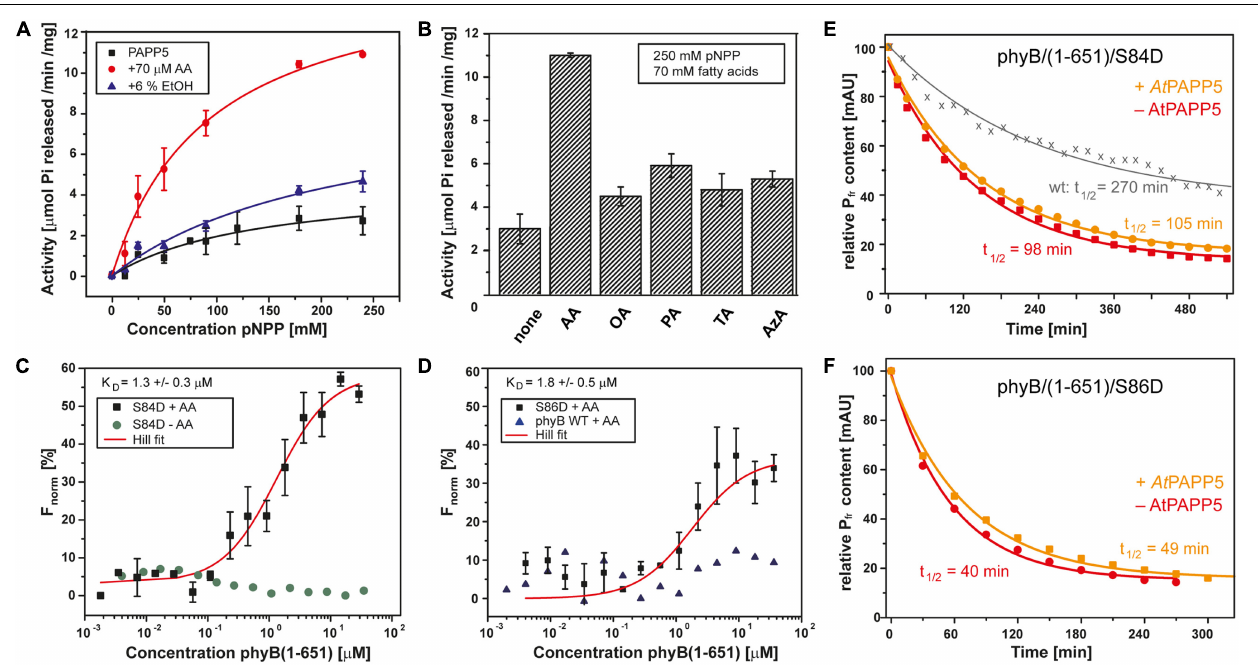
FIGURE 2 | At PAPP5 activity and interaction with the phosphomimic mutants S84D and S86D of phytochrome B. (A) Phosphatase activity (mean ± SD; n = 3) of At PAPP5 in the presence or absence of 70 µ M arachidonic acid (AA) or 6% ethanol (EtOH) and various concentrations of the artificial substrate, p-nitrophenyl phosphate (pNPP). (B) Influence of fatty acids (70 µ M) on the phosphatase activity (mean ± SD; n = 3) of At PAPP5 in the presence of 250 mM pNPP. The line marks the activity of ethanol alone. OA, oleic acid; PA, palmitic acid; TA, traumatic acid; AzA, azaleic acid. (C,D) Microscale thermophoresis experiments show binding (mean ± SD; n = 3) of At PAPP5 toward At PhyB/S86D and At PhyB/S84D. Notably, the S84D achieved no saturation. Therefore, this value should only be regarded as approximation. As negative controls the measurement were done either without AA (C) or with wild-type At PhyB(1-651) (D) . The fitting of experimental data assumed a 1:1 binding model. (E,F) The dark conversion of the S84D and S86D variants (red), in the presence of AtPAPP5 and AA (orange) and the half-lives (t 1 / 2 ) calculated therefrom.